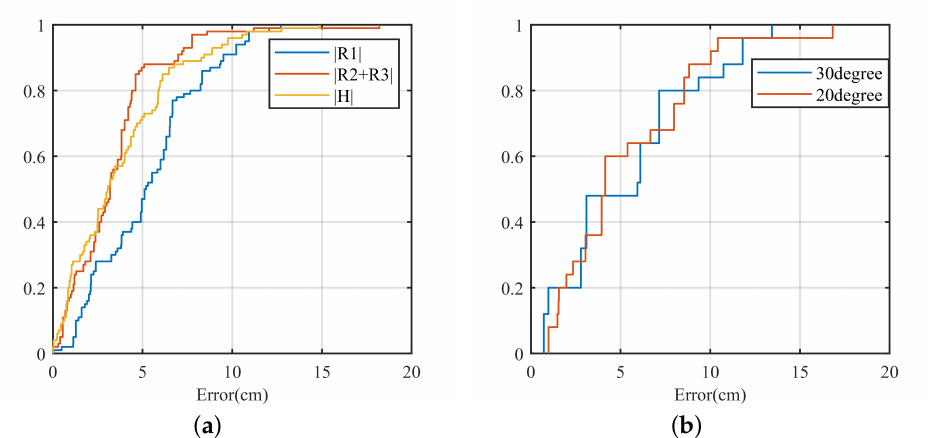
Figure 15. Error accumulation. ( a ) Cumulative error in 3D positioning. ( b ) Multi-target positioning accumulates error.